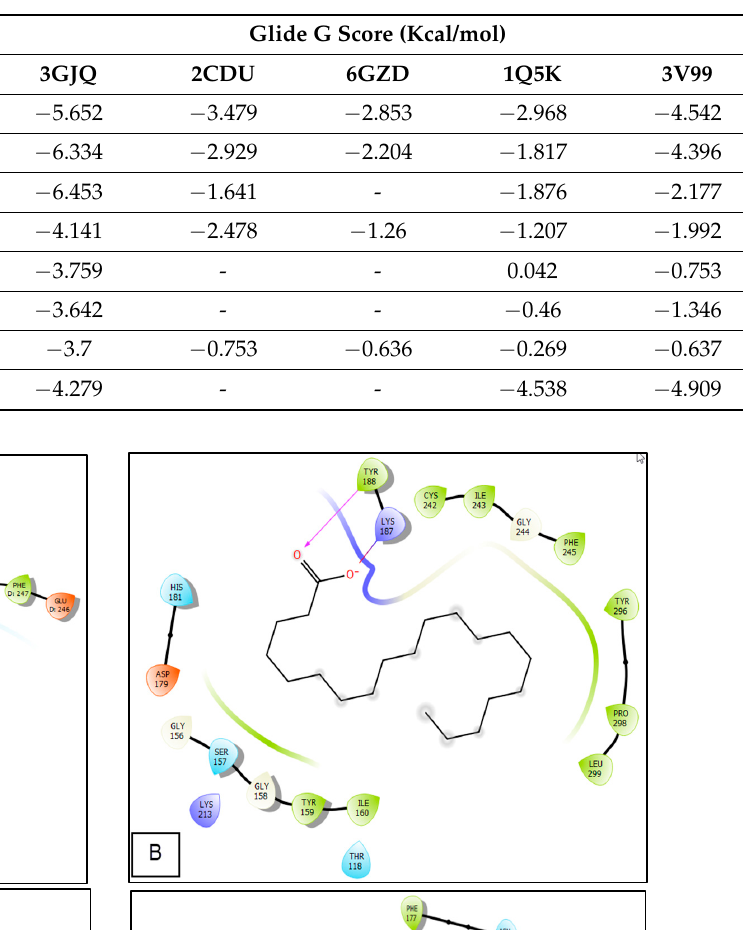
Table 5. Docking results with lipid compounds of C. europaea in the active site of caspase-3, NADPH oxidase, lipoxygenase, CK1, and GSK3- β .